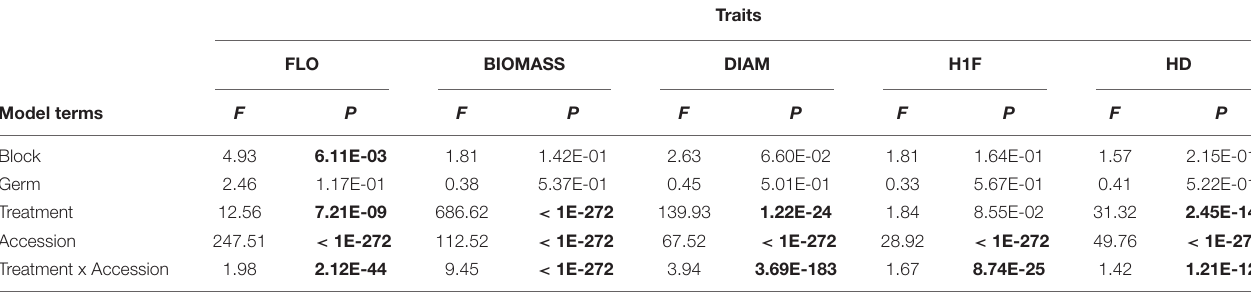
TABLE 1 | Natural variation of five phenotypic traits scored on Arabidopsis thaliana plants in the 12 treatments. Traits FLO BIOMASS DIAM H1F HD